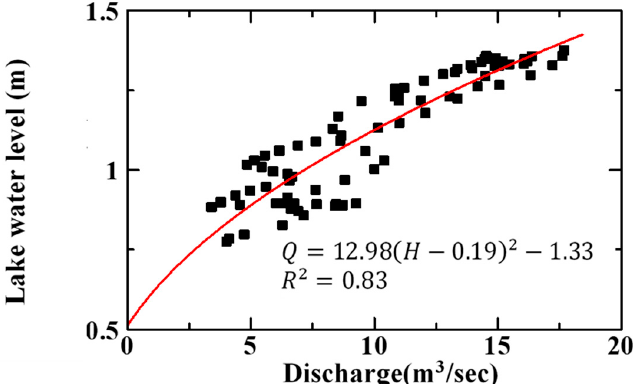
Figure 6. The relationship between the lake water level and the forward flow calculated from the gradient between the lower WL observatory and seawater level.